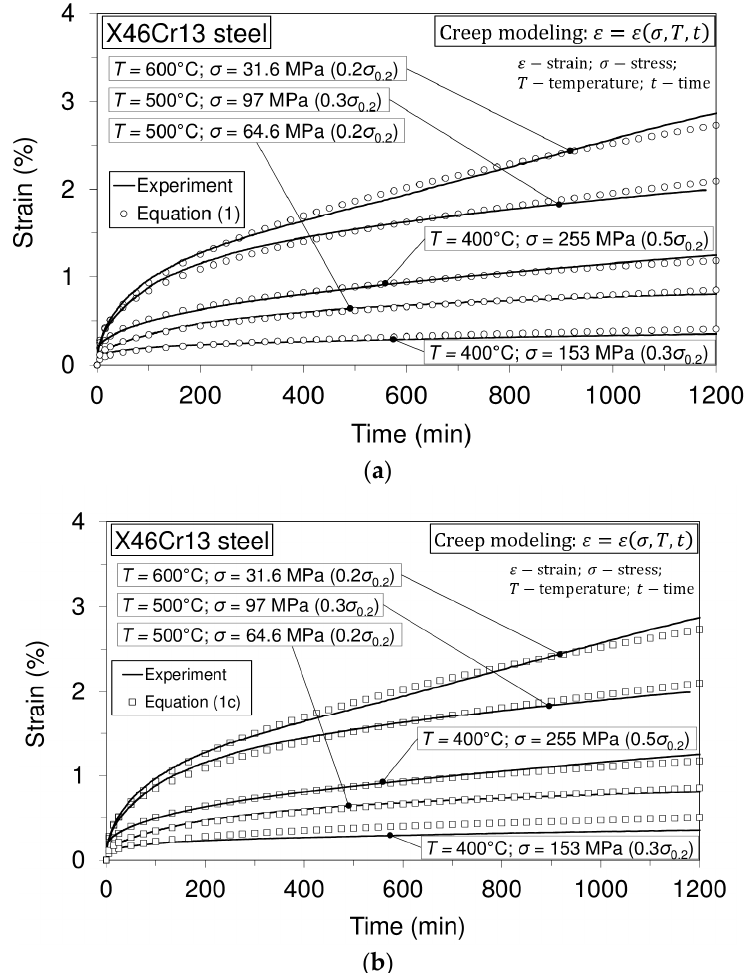
Figure 9. Experimentally-obtained creep curves and modeled creep curves. ( a ) Modeling performed by Equation (1); ( b ) modeling performed by Equation (1c).